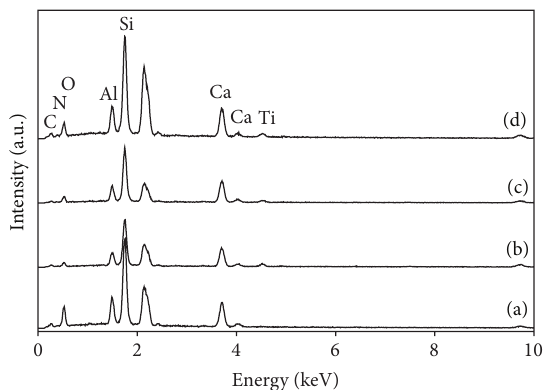
Figure 1: XRD patterns of TiO 2 thin films calcined at 600 ∘ C: (a) TiO 2 , (b) 3SnO 2 /TiO 2 , and (c) 20N/3SnO 2 /TiO 2 . Table 1: Effect of thin film type on its anatase crystallite size, energy band gap, and photocatalytic degradation of MB in 4 h. Samples